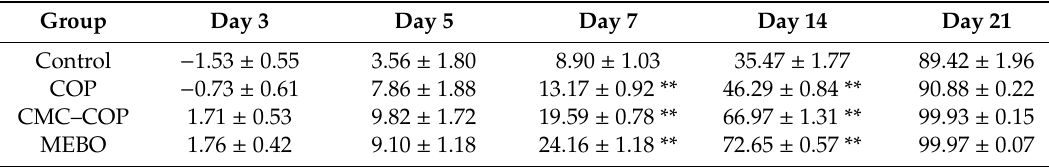
Table 2. Wound healing rates of the COP, CMC–COP, and MEBO groups (%, n = 10).